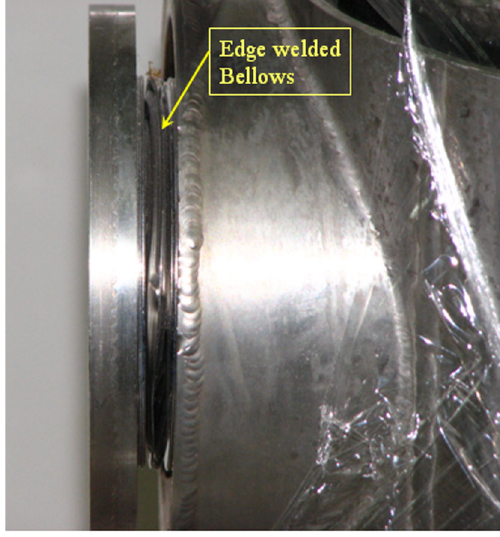
FIG. 12. (Color) Edge welded bellows to join the niobium-SS transition flanges with the SS jacket.